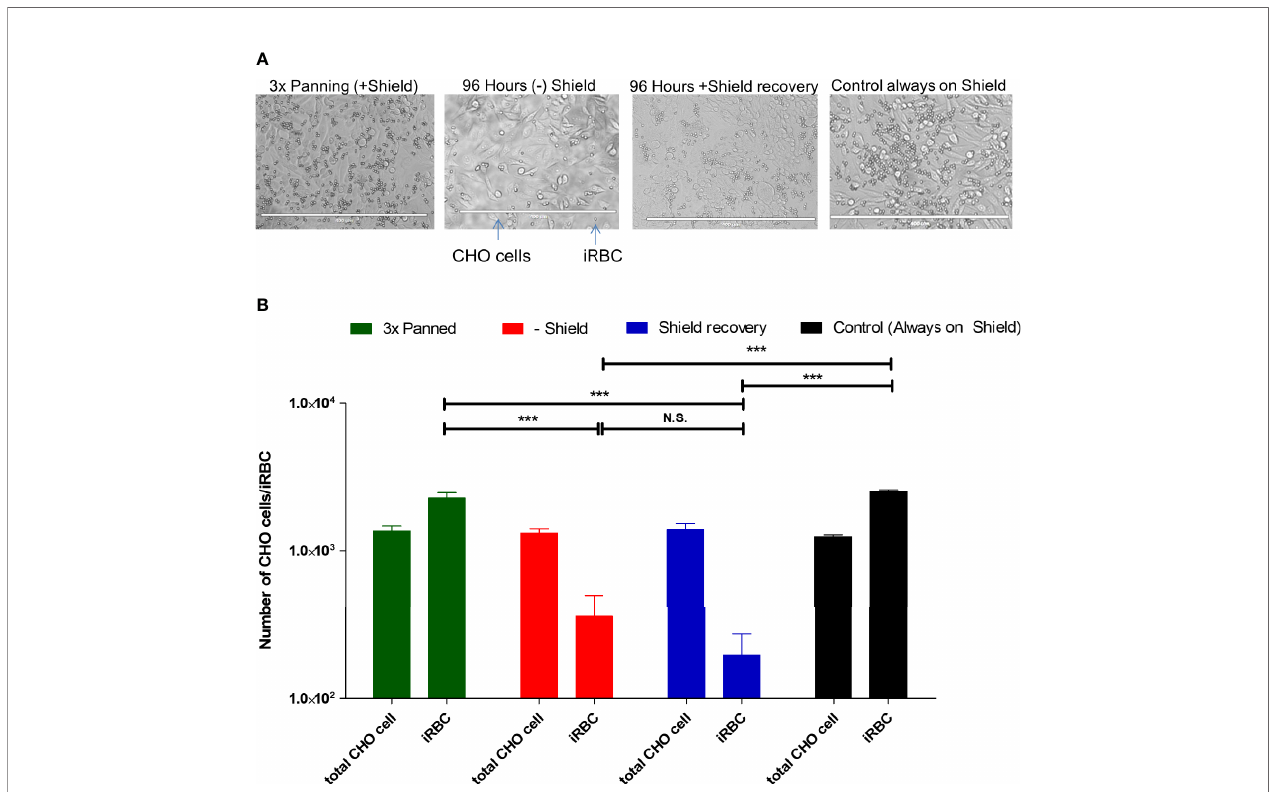
FIGURE 4 | Adherent phenotype analysis shows decreased cytoadherence of IRBC during and after knockdown. (A) Illustrative recording of each condition. From these pictures, cells and the infected red blood cells were counted. The white bar at the bottom of each picture indicates 400 µm. (B) Graphic representation of three independent experiments. The signi fi cance of difference in numbers of adhering iRBC was calculated using Student ’ s T-Test, and three asterisks indicate p values <0.005. N.S. is not signi fi cant. “ Controls ” are the 3× CHO-CD36 selected cultures that were cultivated with Shield-1 throughout the test and analyzed at the same timepoint as the knocked-down and Shield-1 re-added